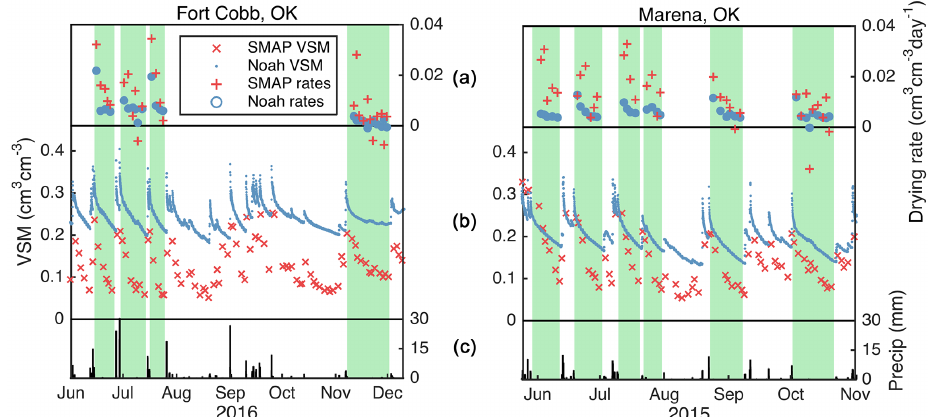
Figure 2. Precipitation (c) , soil moisture (b) , and drying rates (a) for two sites in Oklahoma: Fort Cobb (98.573 ◦ W, 35.342 ◦ E) and Marena ( − 97.217 ◦ W, 36.063 ◦ E). Drydowns are indicated with green shading.